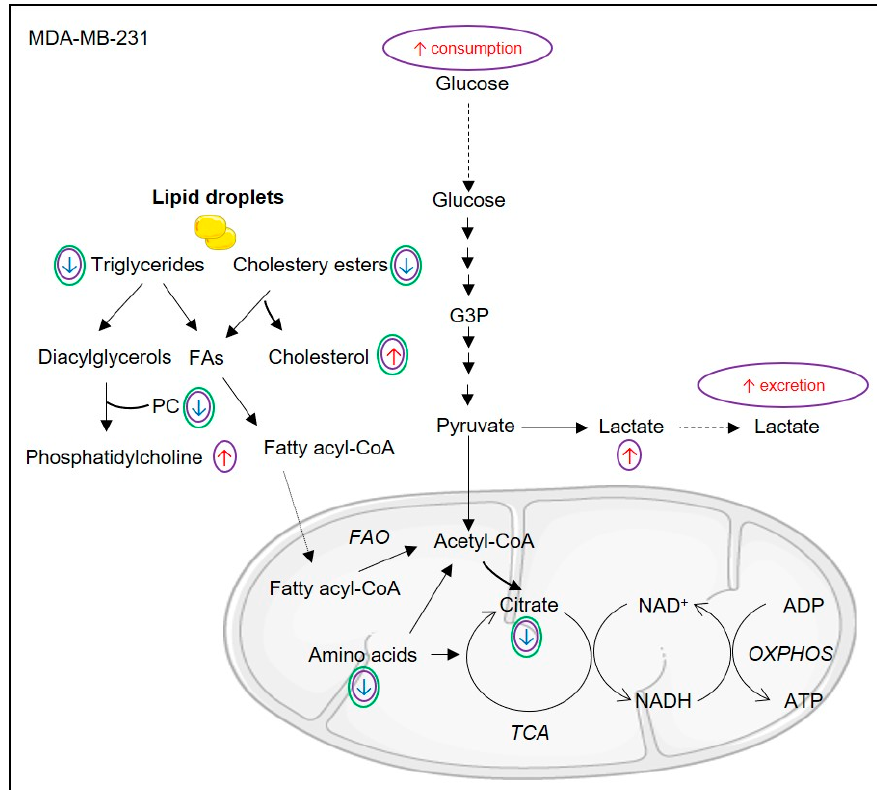
Figure 6. Proposed metabolic reprogramming of MDA-MB-231 breast cancer cells upon 48 h incubation with betulinic acid (BA) or ursolic acid (UA). Effects of BA and UA are represented by purple and green circles, respectively. NAD+/NADH, nicotinamide adenine dinucleotide/reduced form; PC, phosphocholine; FAs, fatty acids; TCA, tricarboxylic acid cycle; OXPHOS; Oxidative phosphorylation. The levels of choline-containing metabolites, which are involved in phospholipid metabolism